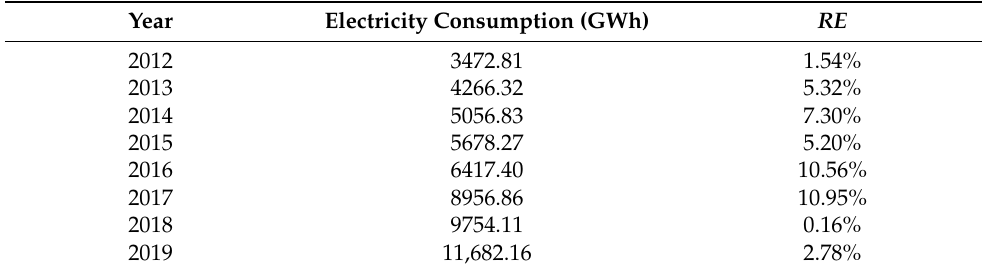
Table 9. Estimated annual electricity consumption in Cambodia,